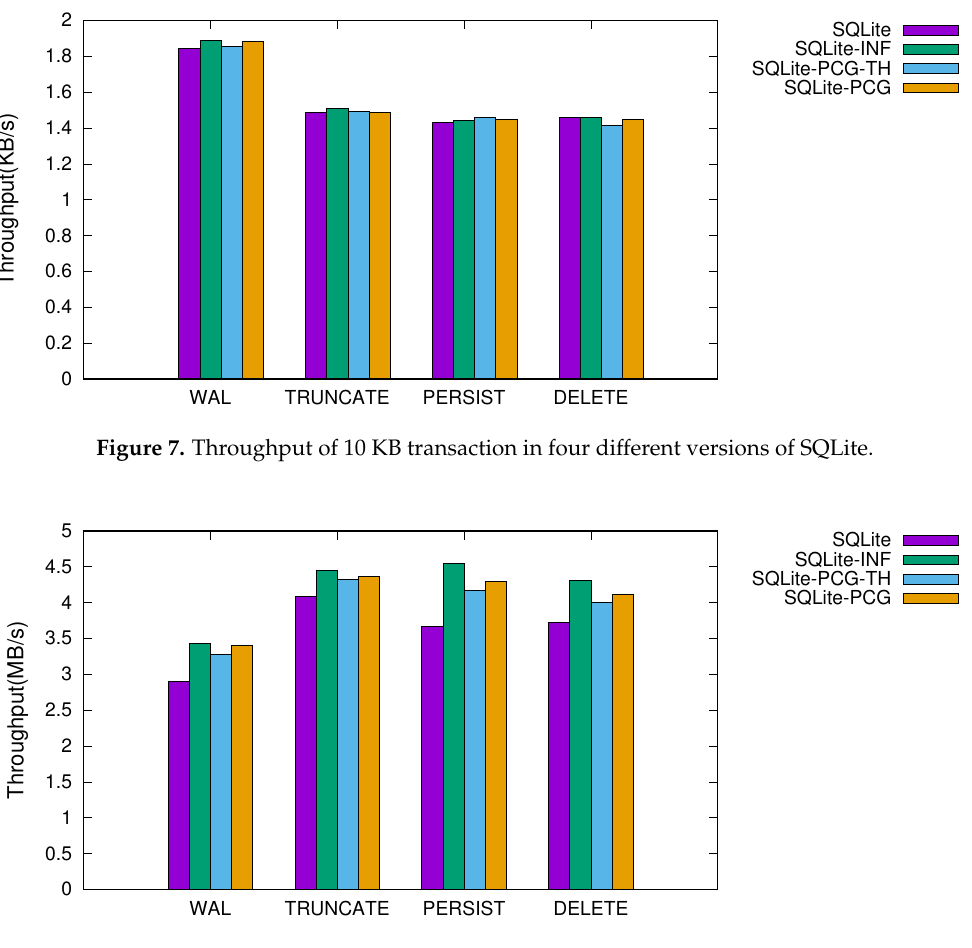
Figure 8. Throughput of 1 MB transaction in four different versions of